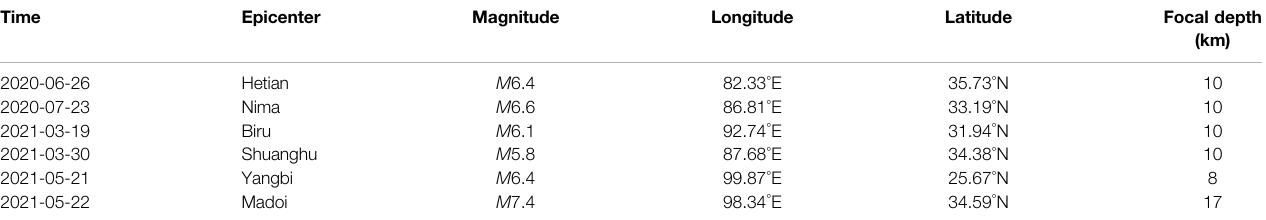
TABLE 1 | Data of moderate and strong earthquakes in the Qinghai-Tibetan Plateau (2020.06 – 2021.05). Time